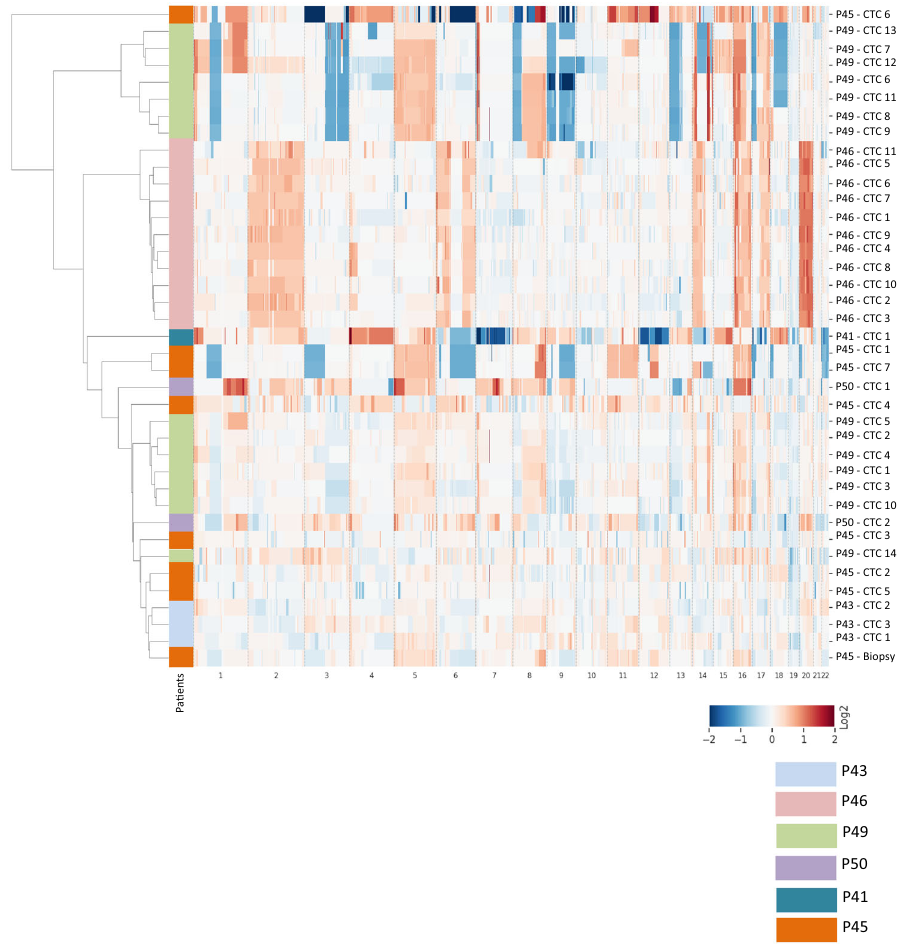
Fig. 3 Hierarchical clustering of CTCs according to low-pass whole-genome CNA from crizotinib-resistant (P43, P46, P49, P50) and lorlatinib-resistant (P41, P45) patients. The heatmap shows the log2 values between − 2 and + 2 with positive values in red (gain) and negative values in blue (loss) respectively to the main chr7) gain in CTC 1 of P43 and in single CTCs of P50, and cyclin- dependent kinase 4 ( CDK4 , chr12) gains in 5/7 CTCs of P45 and the corresponding tumor biopsy. The most common CNA losses in cell cycle-related pathways included the tumor repressor RB1 (33.3%) and adjacent cyclin-dependent kinase inhibitor genes ( CDKN2A and CDKN2B , chr9) (30.8%). Gains of DNA damage-related proto- oncogenes MDM2 (chr12) and MDM4 (chr1) were frequent across CTC samples except in P43 and P46. Usually considered as an early event, the loss of tumor suppressor TP53 was detected in 41% of CTC samples. However, despite multiple losses, at least one copy of the TP53 gene was preserved in all evaluated samples. Complex alterations of chromosome 3 in CTC 6 of lorlatinib-relapsing P45 resulted in a complete loss (0 copy) of two homologous recombinations (HR)-related genes: BRCA1 associated protein 1 ( BAP1 ) and Fanconi anemia complementation group D2 ( FANCD2 ). In addition, the same CTC harbored a complete loss of mutL homolog 1 (MLH1), a DNA mismatch repair gene. The RTK/RAS- related pathway, which was previously found mutated 27 , was also altered with 15 CNAs. CTCs from P46, P49, and P45 (30.8% of CTC samples) harbored gains in erb-b2 receptor tyrosine kinase 2 ( ERBB2 , chr17). Gains of epidermal growth factor receptor ( EGFR , chr7), fi broblast growth factor receptor 1 ( FGFR1 , chr8), v-ki-ras2 kirsten rat sarcoma 2 viral oncogene homolog ( KRAS , chr12), raf-1 proto-oncogene ( RAF1 , chr3), and alterations in downstream effectors of RTK/RAS signaling mitogen-activated protein kinase